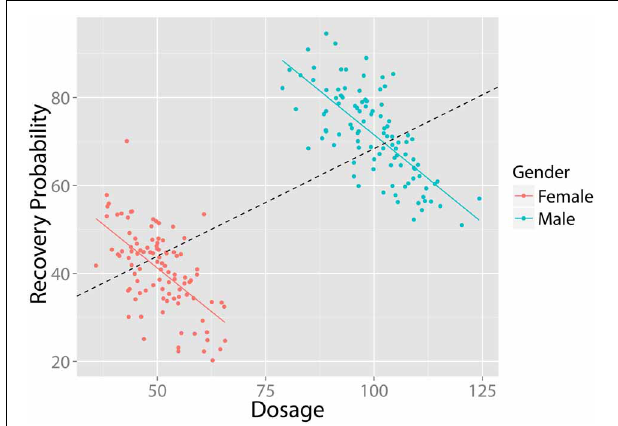
FIGURE 1 | Example of Simpson’s Paradox. Despite the fact that there exists a negative relationship between dosage and recovery in both males and females, when grouped together, there exists a positive relationship. All figures created using ggplot2 (Wickham, 2009). Data in arbitrary